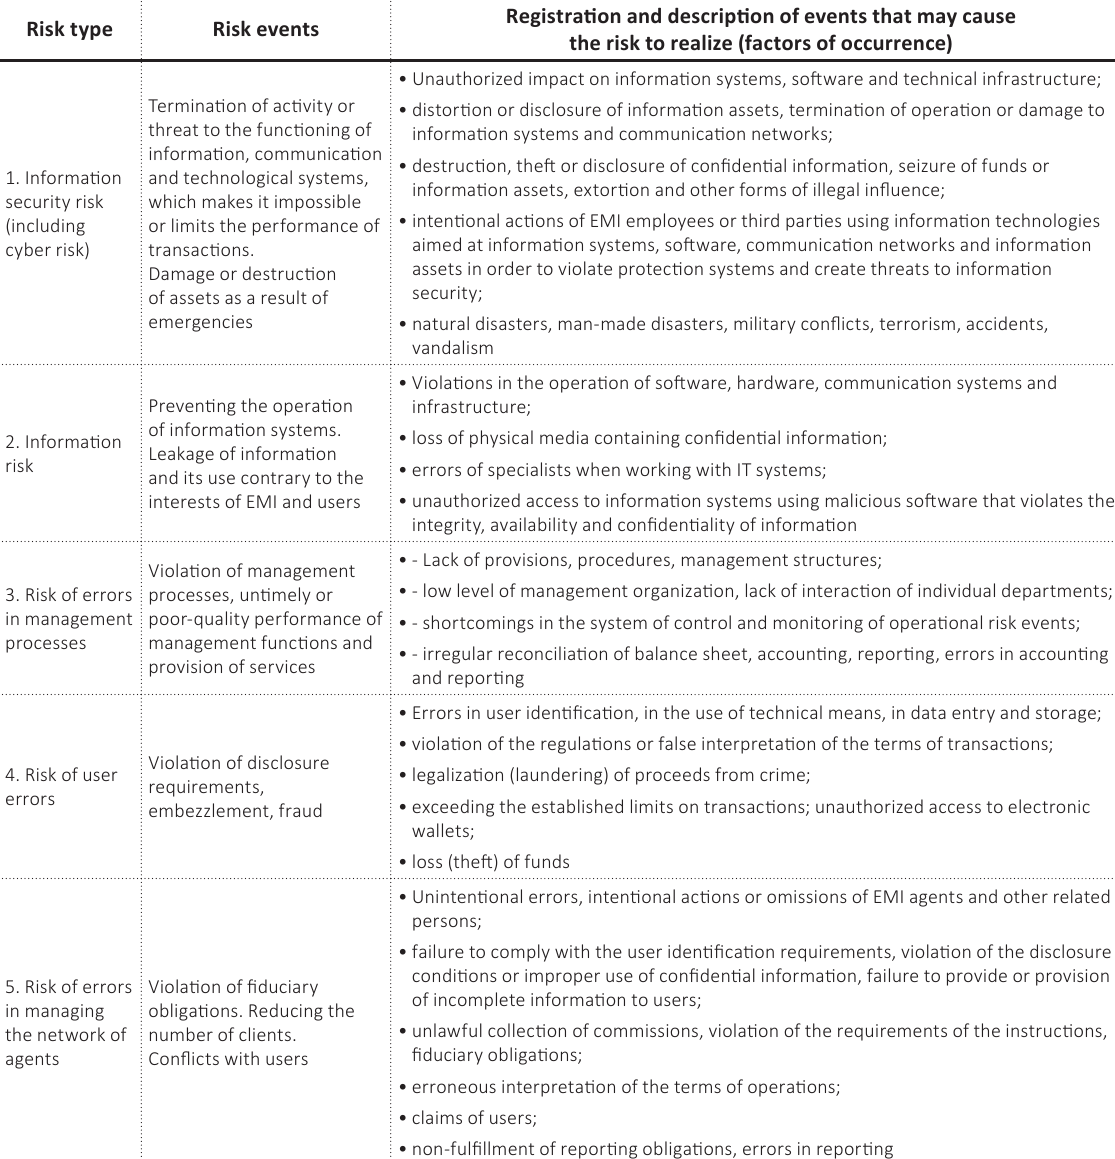
Table 4. Characteristics of operational risk manifestation forms in electronic and mobile money payment